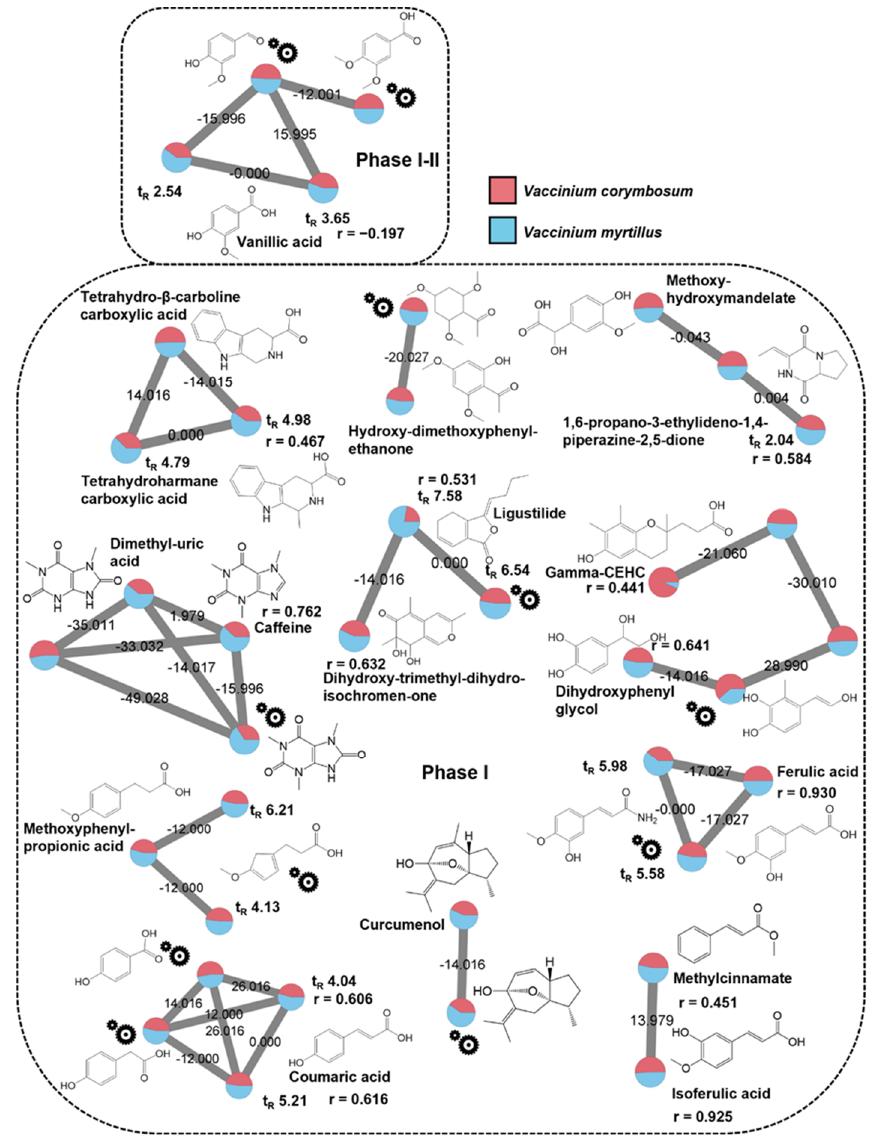
Figure 4. Extracted molecular families of identified metabolites in positive ionization mode listed in Table S2, belonging to the category of (poly)phenolic derivatives and plant endogenous constituents. Dashed boxes group the identified metabolites according to the phase I and II metabolism following PPMC analysis. The “gear” symbols refer to the putative structure identified by manual investigation as reported in Section 2.6 of the main text. Statistically significant Pearson correlation coefficients (r) are reported. Edge labels refer to the mass difference between two nodes.